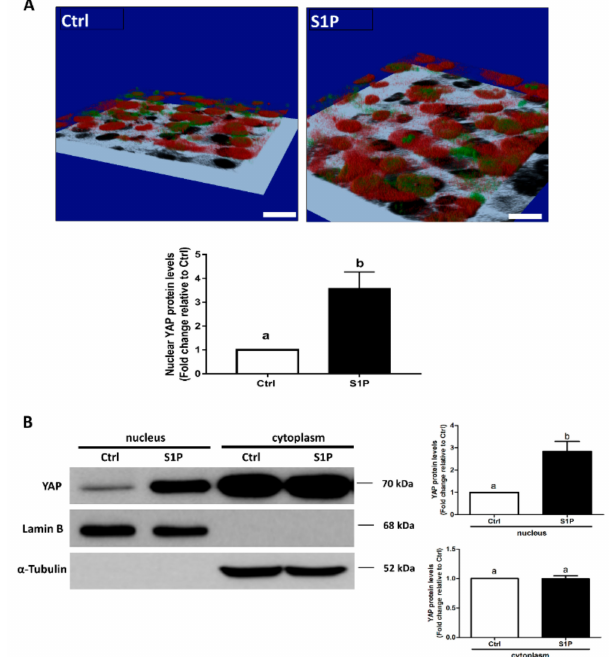
Figure 5. S1P induces nuclear translocation of Yes-associated protein (YAP) in SVOG cells. ( A ) SVOG cells were treated with a vehicle control or 0.3 µ M S1P for 30 min; the subcellular localization of YAP was determined using immunofluorescence staining for endogenous YAP (red) along with DAPI staining to show nuclei (green); the 3D images were acquired with a confocal microscope. The yellow pixels of the colocalized region indicate the intranuclear localization of YAP. Black speckles indicate the shadows of SVOG cells. Scale bars represent 50 µ m. ( B ) SVOG cells were treated with a vehicle control or 0.3 µ M S1P for 1 h. The protein levels of YAP in the cytoplasmic and nuclear fractions were examined using western blot analysis. Lamin B and α -Tubulin were used as the control proteins for the cytoplasmic and nuclear fractions, respectively. The results are presented as the mean ± SEM of at least three independent experiments. If a pair of values is significantly di ff erent ( p < 0.05), the values have di ff erent subscript letters (a vs. b or b vs. c) assigned to